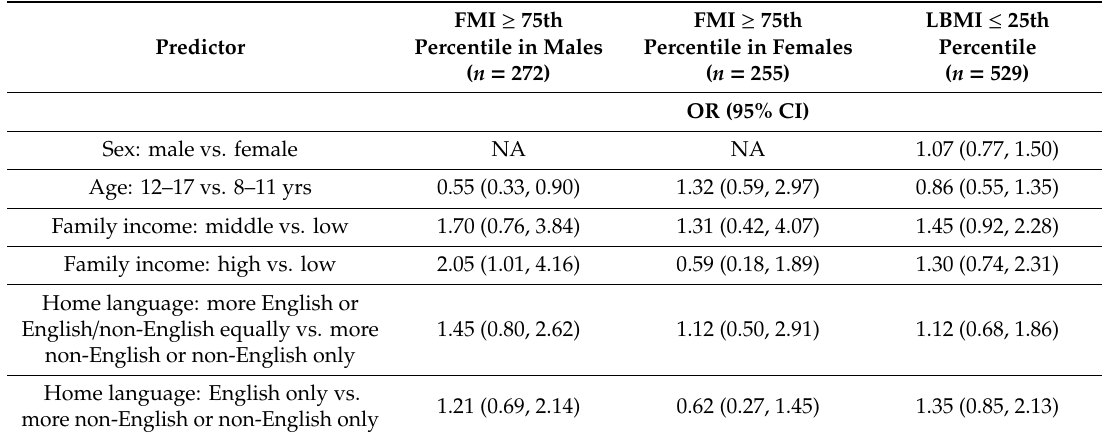
Table 4. Associations of acculturation with elevated FMI and low LBMI in Asian American children. Predictor